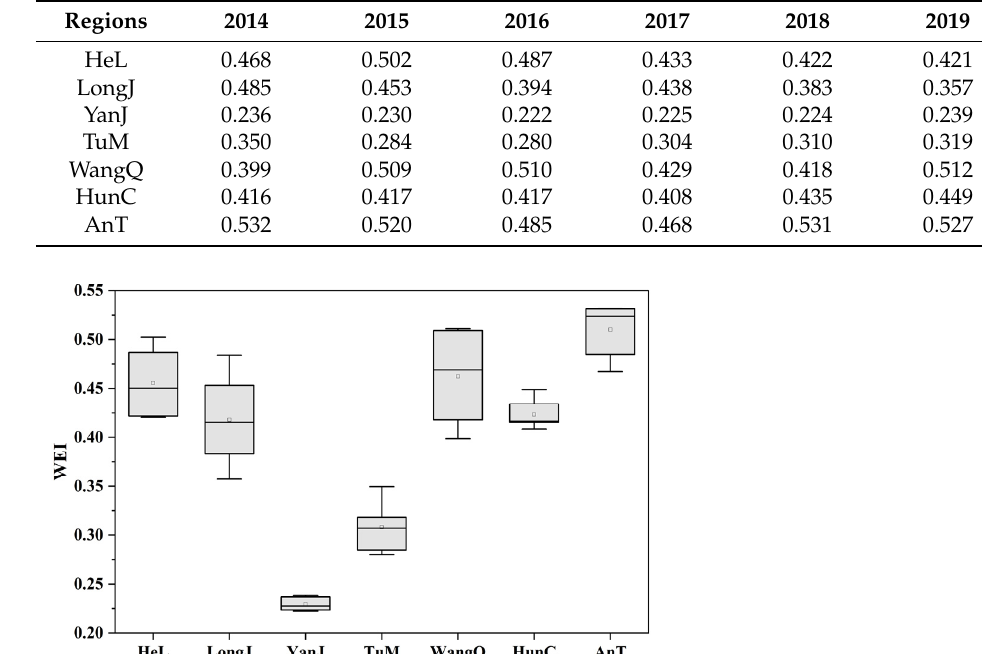
Figure 14. Comparison of water resource utilization efficiency index (WEI) in the TRB’s regions.